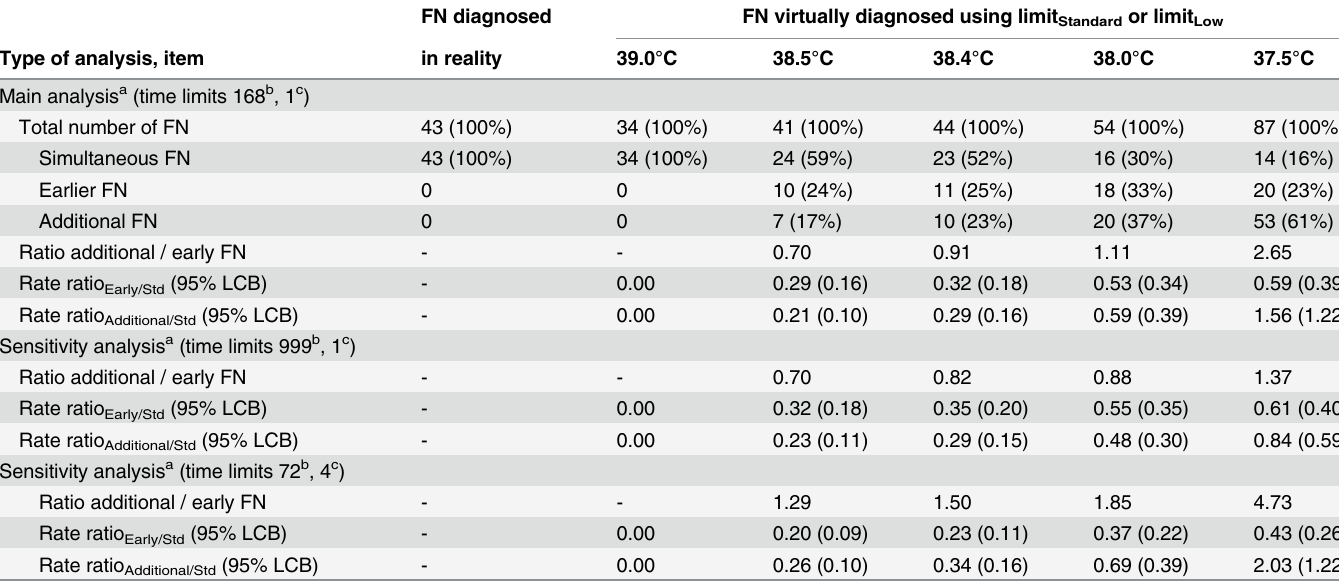
Table 2. Frequency of FN Episodes Diagnosed in Reality, and Virtually at Different Temperature Limits De fi ning Fever. FN diagnosed FN virtually diagnosed using limit Standard or limit